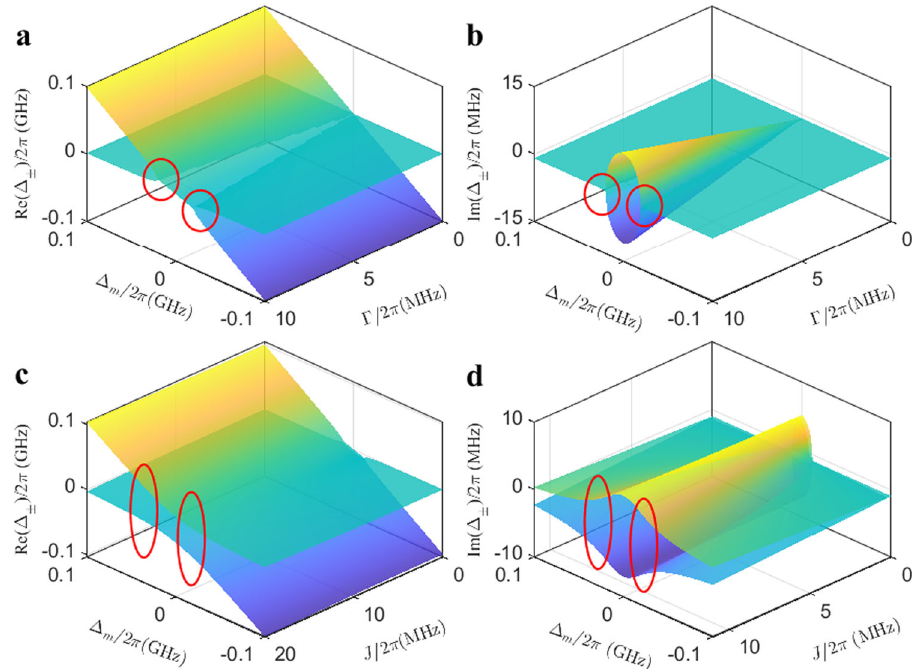
Fig. 2 Energy-level anti-crossing in the dissipative mechanism induced by coherent coupling. a , c Real parts and b , d imaginary parts of the eigenvalues of the Hamiltonian versus Δ m , a , b Γ and c , d J . The parameters are set as J /2 π = 0 in a and b , Γ /2 π = 6 MHz in c and d , the other parameters are ω c /2 π = 10 GHz, κ /2 π = γ /2 π = 6 MHz, α /2 π = β /2 π = 1 MHz, θ = 0, and T = 20